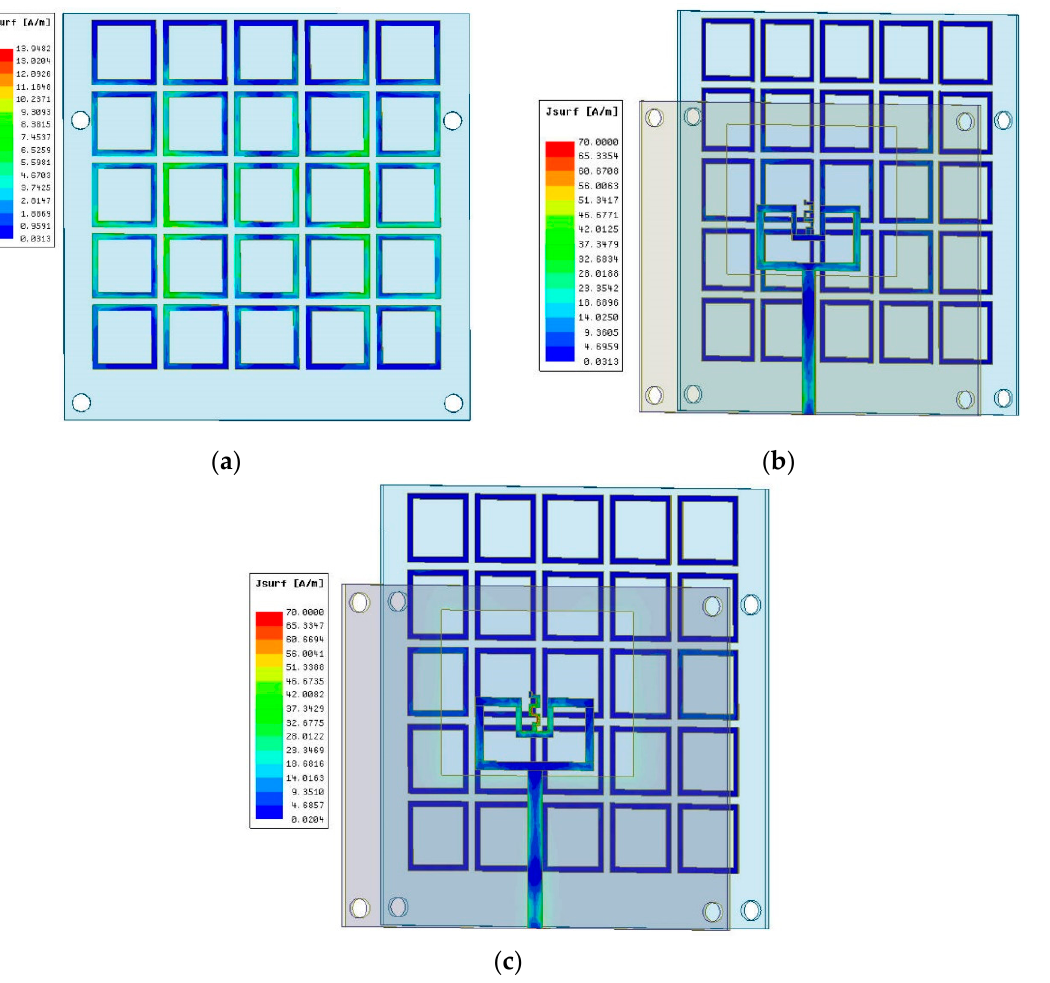
Figure 16. Current distribution of ( a ) the FSS and the antenna with an FSS at ( b ) 2.45 GHz and ( c ) 5.8 GHz.